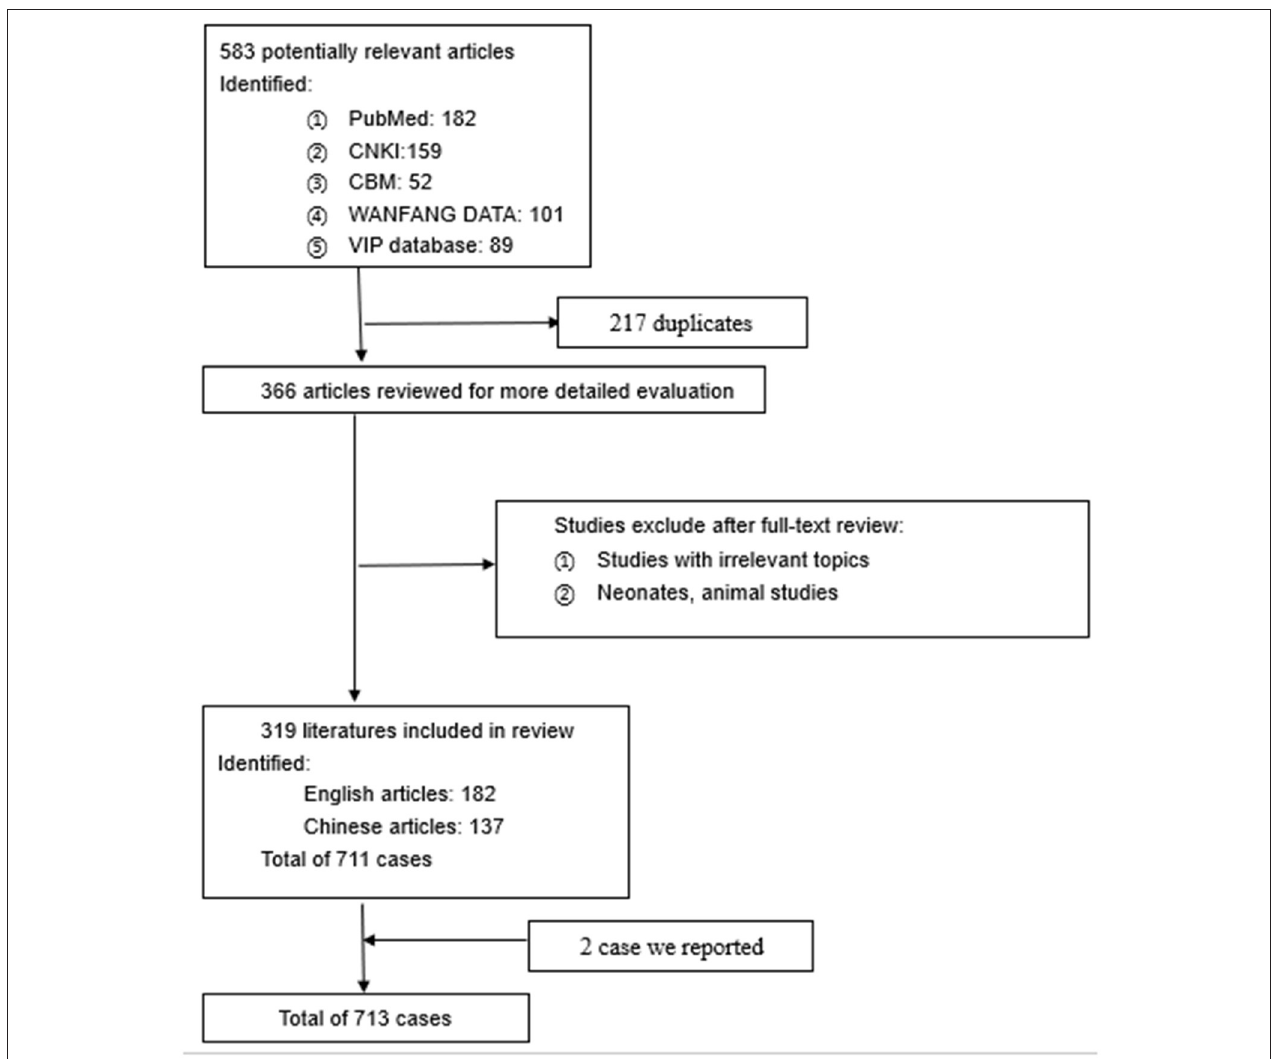
FIGURE 3 | The process of the literature